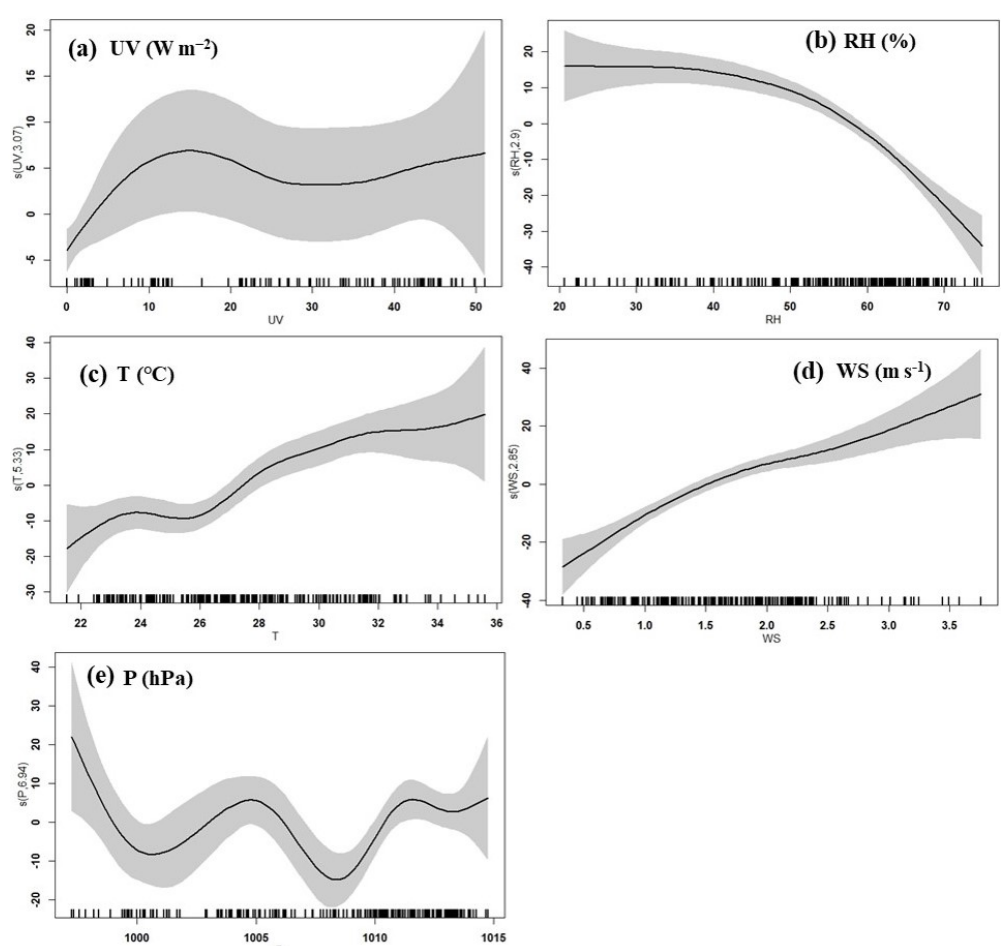
Figure 13. Response curves in the GAM of O 3 concentration to changes in (a) ultraviolet radiation (UV), (b) relative humidity (RH), (c) temperature ( T ), (d) wind speed (WS), and (e) pressure ( P ). The y axis shows the smoothing function values. The x axis shows the influencing factor; the vertical short lines represent the concentration distribution characteristics of the explanatory variables, and the shaded area around the solid line indicates the 95% confidence interval of O 3